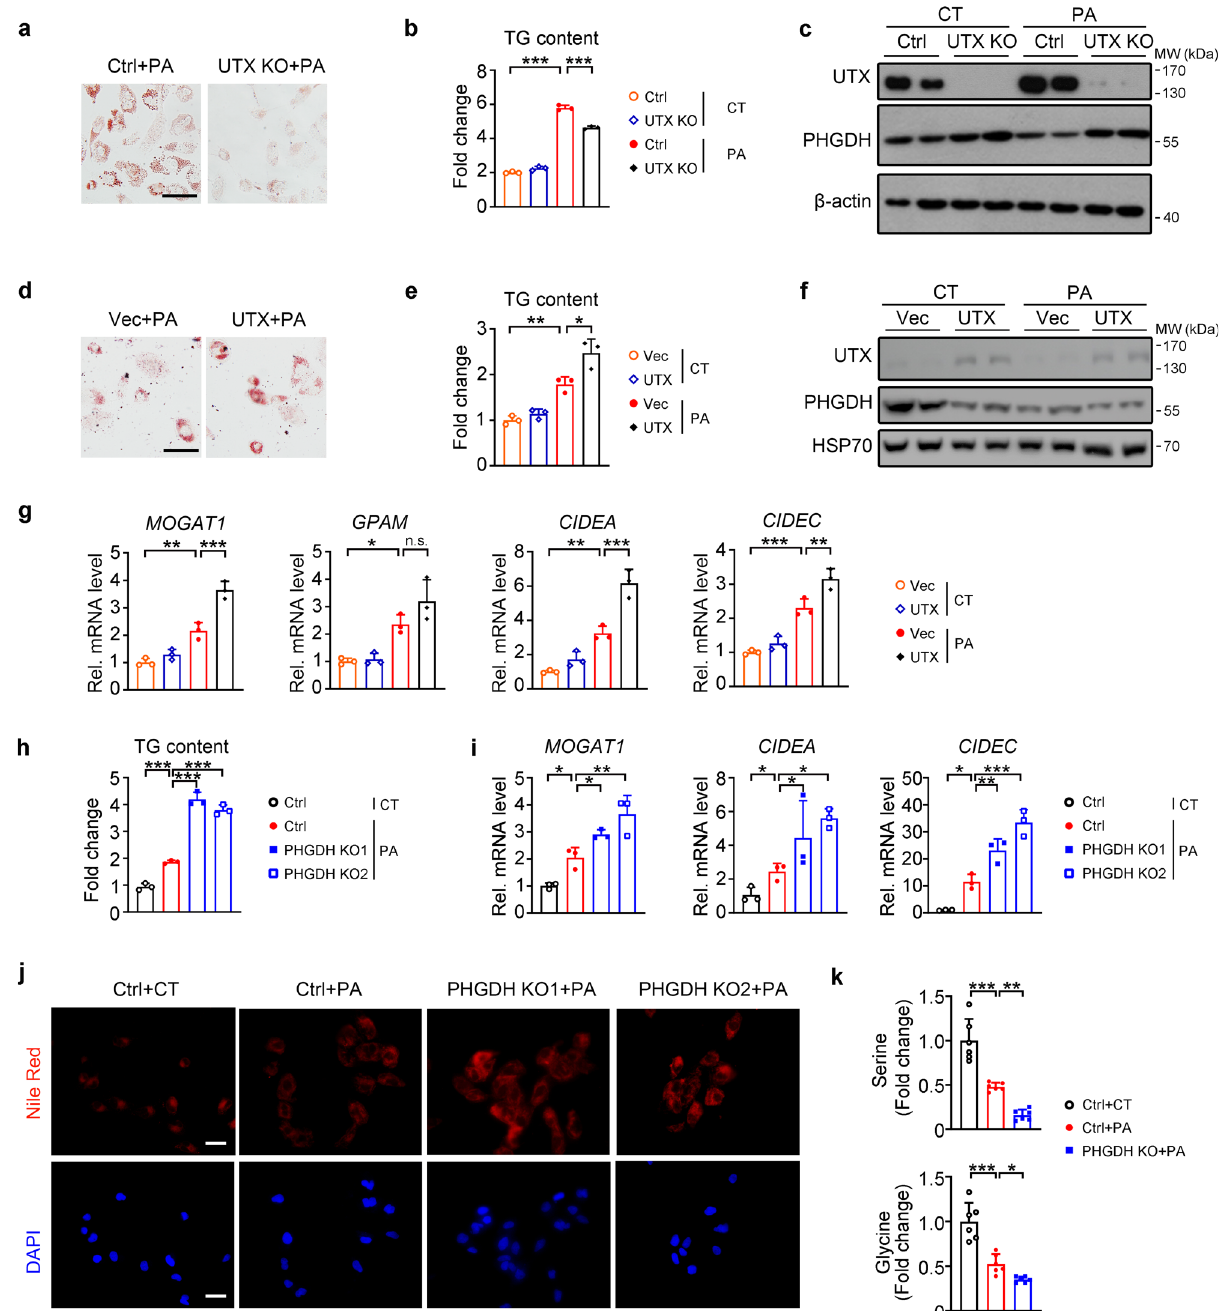
Fig. 6 UTX and PHGDH regulated lipid level in cultured renal cells. a – c UTX knockout prevented PA-induced lipid accumulation in HK-2 cells. Oil Red O staining ( a ), TG level ( b ) and PHGDH level ( c ) in UTX knockout HK-2 cells with or without PA stress. b n = 3 biological samples (mean±SD), *** P TG (Ctrl + CT vs Ctrl = 2 biological samples per group. d – g UTX overexpression exacerbated PA-induced + PA) <0.0001; *** P TG (Ctrl + PA vs UTX KO + PA) <0.0001 ( one-way ANOVA); ( c ) n lipid accumulation in HK-2 cells. Oil Red O staining ( d ), TG level ( e ), PHGDH level ( f ) and transcriptional levels of TG synthesis/lipid storage related genes ( g ) in UTX overexpressin g HK-2 cells. e , g n = 3 biological samples (mean±SD), ** P TG (Vec + CT vs Vec + PA) = 0.0063, * P TG (Vec + PA vs UTX + PA) = 0.0119; ** P MOGAT1(Vec + CT vs Vec + PA) = 0.0033, *** P MOGAT1(Vec + PA vs UTX + PA) = 0.0009; * P GPAM (Vec + CT vs Vec + PA) = 0.0293; ** P CIDEA (Vec + CT vs Vec + PA) = 0.0038, *** P CIDEA (Vec + PA vs UTX + PA) = 0.0009; = 0.0009, ** P = 0.0076 (one-way ANOVA); ( f ) n = 2 biological samples per group. h – k PHGDH knockout *** P CIDEC (Vec + CT vs Vec + PA) CIDEC (Vec + PA vs UTX + PA) aggravated PA-induced lipid accumulation and reduced cellular serine/glycine levels in HK-2 cells. TG level ( h ), transcriptional levels of TG synthesis/storage related genes ( i ), Nile Red staining ( j ) and cellular serine ( k , top) or glycine ( k , bottom) level in PHGDH knockout HK-2 cells. Scale bar, 50 μ m. h – j n = 3 biological samples per group, ( k ) n = 6 biological samples per group (mean±SD). *** P TG (Ctrl + CT vs Ctrl + PA) = 0.0006, *** P TG (Ctrl + PA vs PHGDH KO1 + PA) <0.0001, *** P TG (Ctrl + PA vs = 0.0351, * P = 0.0408, ** P = 0.0034; * P * P MOGAT1 (Ctrl + CT vs Ctrl + PA) MOGAT1(Ctrl + PA vs PHGDH KO1 + PA) MOGAT1 (Ctrl + PA vs PHGDH KO2 + PA) CIDEA(Ctrl + CT PHGDH KO2 + PA) <0.0001; = 0.0230, * P = 0.0495, * P = 0.0289; * P = 0.0158, ** P vs Ctrl + PA) CIDEA (Ctrl + PA vs PHGDH KO1 + PA) CIDEA (Ctrl + PA vs PHGDH KO2 + PA) CIDEC (Ctrl + CT vs Ctrl + PA) CIDEC (Ctrl + PA vs